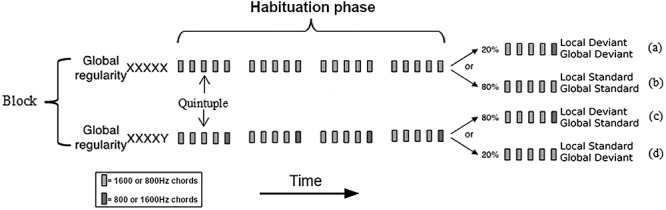
Local-global auditory task design from (Bekinschtein et al. 2009).